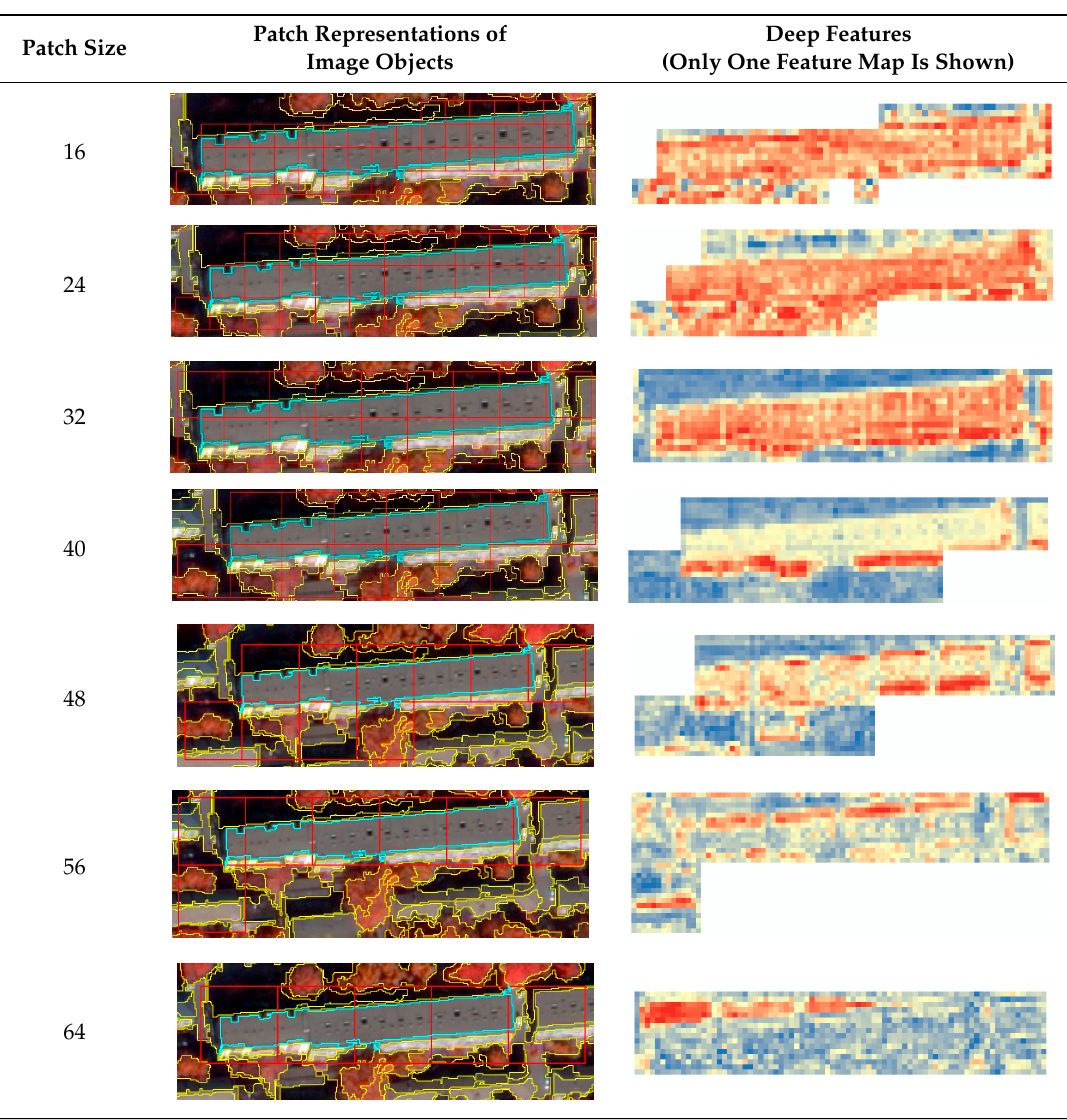
Table 3. Patch representations of image objects (yellow lines represent geographic objects and red lines represent patches) and the learned deep features (red represents high value and blue represent low value) with different patch sizes.